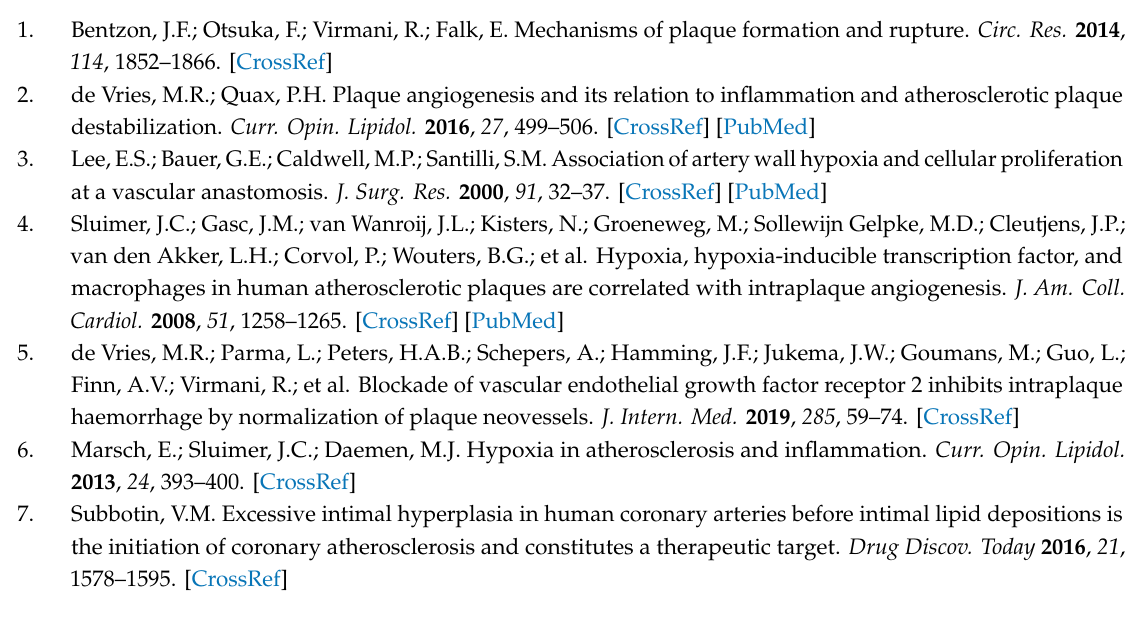
Figure S1: Bodyweight and cholesterol levels acute carbogen exposure, Figure S2: Bodyweight and cholesterol levels chronic carbogen exposure, Figure S3: Total wall gene expression, Figure S4: inflammatory gene expression in cultured BMM, Figure S5: BMM 8OHdG